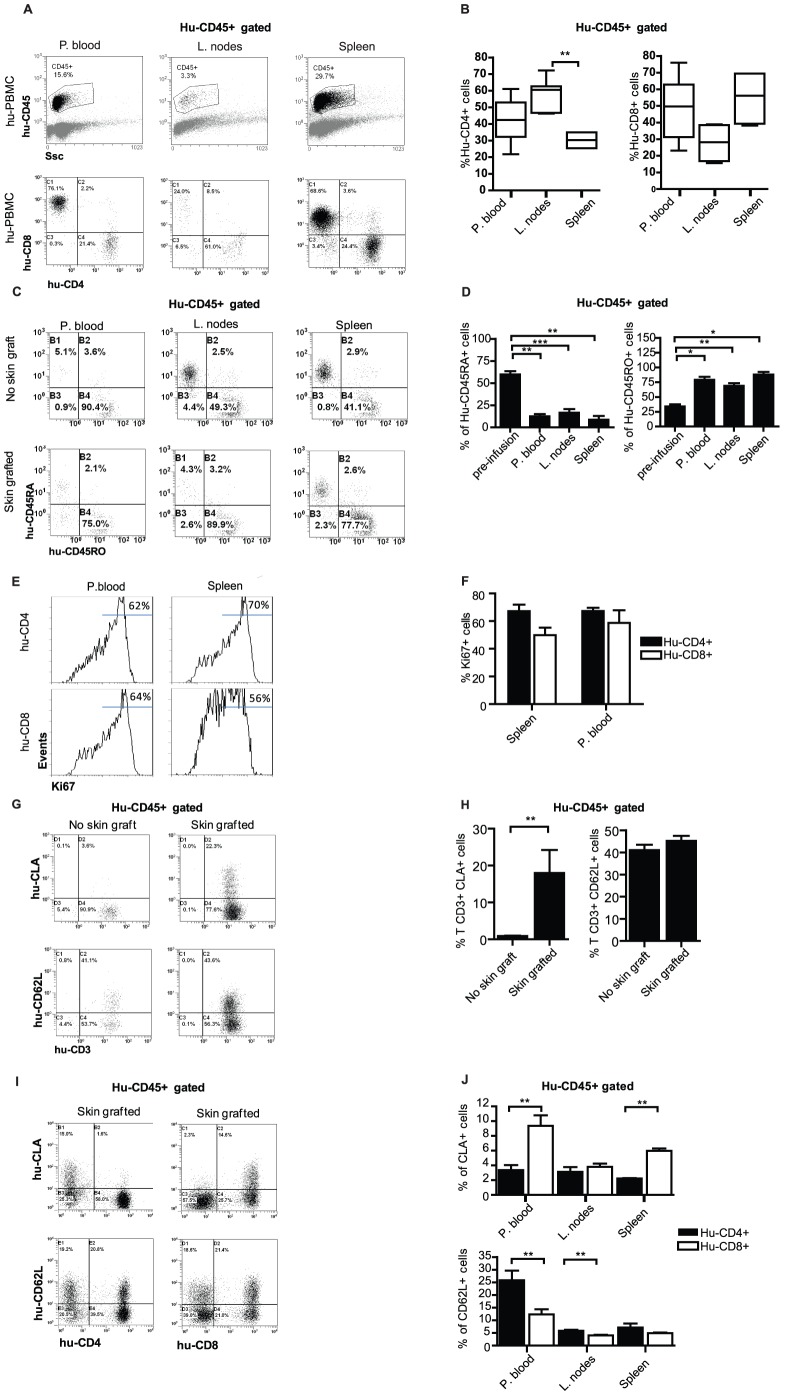
Systemic human CD4 and CD8 T cell activation, proliferation and acquisition of homing markers in the SCID/skin allograft mouse model.
A. Flowcytometry showing side scatter (SSC, X-axis) and CD45 expression (Y-axis) (top panel) and CD4 (X-axis) and CD8 (Y-axis) expression (lower panel) in peripheral blood and lymph node and spleen cell suspensions 21 days after infusion or huPBMC. Representative dotplots are shown (n = 4–7). CD4/CD8 expression is shown after gating on huCD45+ cells. In case of PBS infusion hardly any human CD45+ lymphocytes was detected (data not shown). B. Summarized flowcytometry data of human CD4+ and CD8+ cells upon huPBMC infusion as shown in A. (n = 6). C. Flowcytometry of human CD45RO+ (X-axis) and CD45RA+ (Y-axis) cell populations in peripheral blood and lymph node and spleen cell suspensions 21 days after infusion of huPBMC in SCID beige mice that either lacked (top panel) or were previously grafted with human skin (lower panel) Representative dotplots gated on huCD45+ cells are shown. D. Summarized flowcytometry data of CD45RO+ and CD45RA+ cells upon huPBMC infusion in SCID beige mice that were grafted with human skin as shown in C. (n = 6). E. Flowcytometry of Ki67 expression in CD4+ (top panel) and CD8+ (lower panel) human T cells in peripheral blood (left) and spleen (right). F. Summarized flowcytometry data of Ki67 expression in CD4+ and CD8+ human T cells as shown in E. (n = 6). G. Flowcytometry of CLA (top panel) and CD62L (lower panel) expression on human CD3+ cells populations in peripheral blood, 21 days after infusion of huPBMC in SCID beige mice that either lacked (right panel) or were previously grafted with human skin (right panel) Representative dotplots gated on huCD45+ cells are shown. H. Summarized flowcytometry data of CLA and CD62L expression on human CD3+ cells as shown in G. (n = 4–5). I. Flowcytometry of CLA (top panel) and CD62L (lower panel) expression on human CD4+ (left) and CD8+ (right) cells in peripheral blood, 21 days after infusion of huPBMC in SCID beige mice that previously grafted with human skin. Representative dotplots gated on huCD45+ cells are shown. J. Summarized flowcytometry data of CLA and CD62L expression on human CD4+ and CD8+ cells as shown in peripheral blood, lymph nodes and spleen. (n = 4–5).